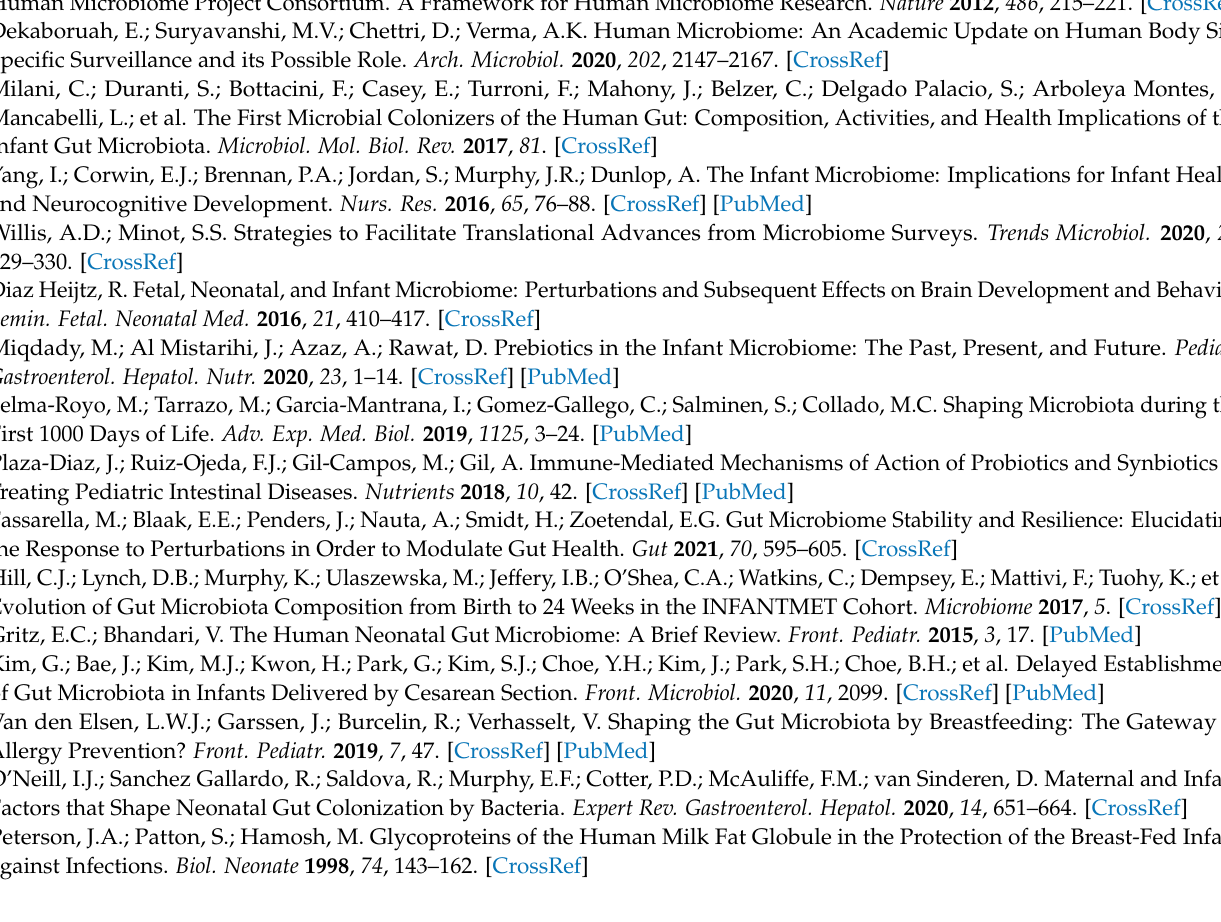
human samples at the genus level. Table S3: DeSeq genus-level analysis of lumen vs. mucosa-derived sample in jejunum, ileum and colon regions. Table S4: DeSeq analysis at genus level in mice in the mucosa between jejunum, ileum and colon regions. Table S5: DeSeq analysis at genus level in mice in the lumen between jejunum, ileum and colon regions. Table S6: Genus level analysis of mouse sample: absolute read numbers and relative abundances per